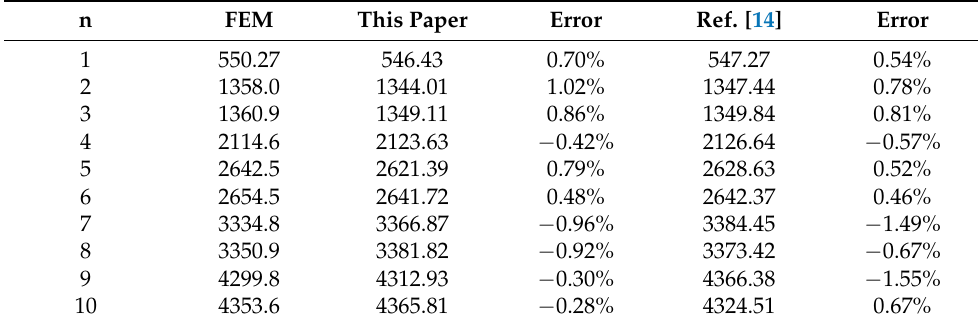
Table 1. The first ten natural frequencies of the honeycomb sandwich plate with